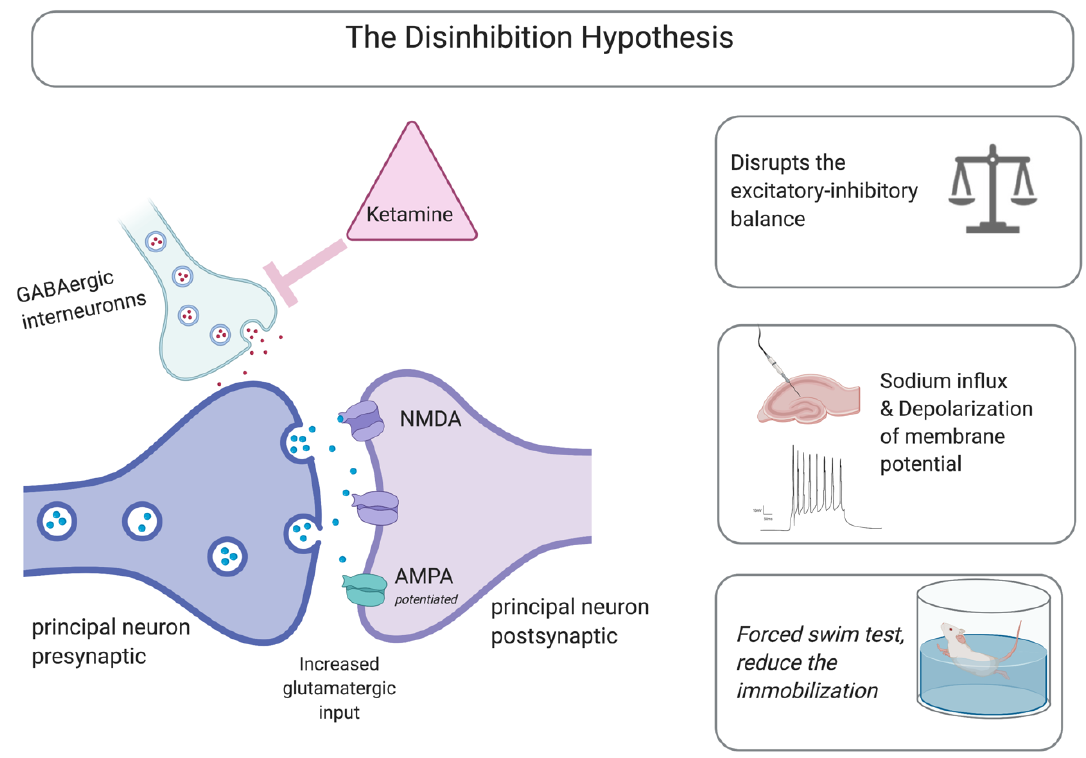
Figure 1. Main mechanisms described in the disinhibition hypothesis. Created with BioRender.